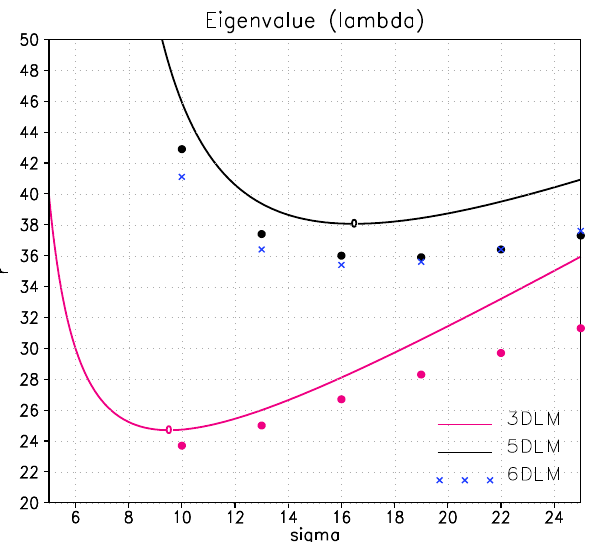
Figure 7. The r c of the 6DLM as a function of σ . The r c , shown by blue multiplication signs ( X ), is determined by the eLEs of the non- linear 6DLM. The pink and black lines indicate a constant contour of Re (λ) = 0 for the linear 3DLM and 5DLM, respectively, indicat- ing the corresponding r c , based on a linear stability analysis. Solid circles with the same color scheme indicate a r c , determined by the eLE analysis with (cid:49)r = 0 . 1 in the corresponding nonlinear